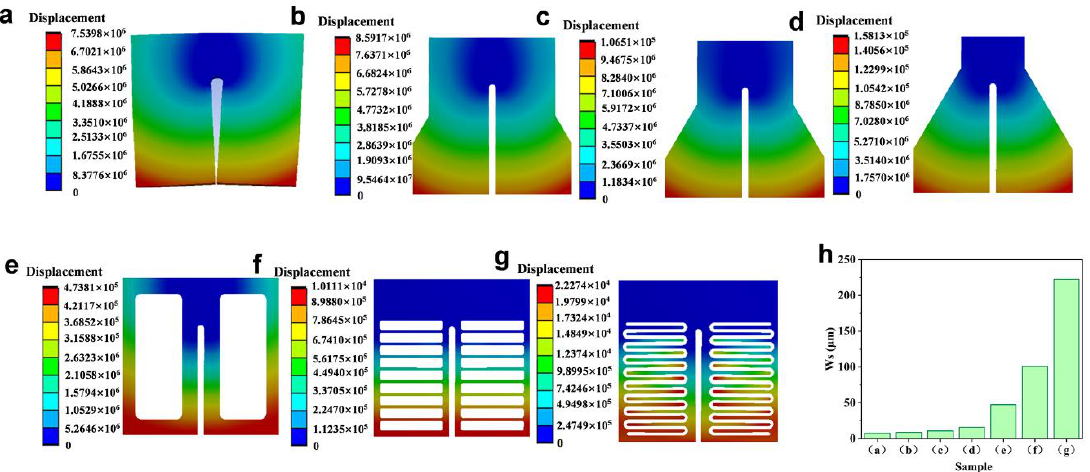
Figure 5. The influence of the effective removal area on the deformation of slit wake. ( a – g ) Finite- element-simulation analysis of the influence of different “hollow out” structures on the deformation of slit wake. ( h ) The statistical results of the slit-wake deformation for the samples from ( a – g ) with different “hollow out” structures.